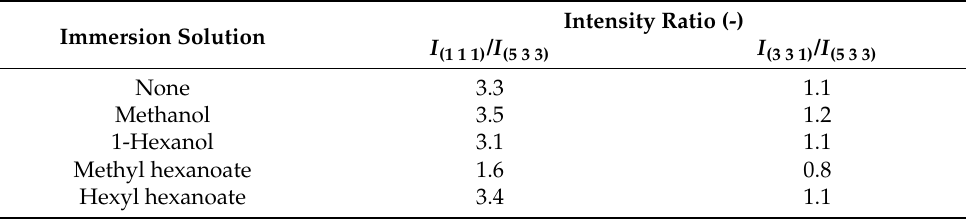
Table 2. XRD peak intensity ratio of the FAU powders immersed in alcohols and esters.